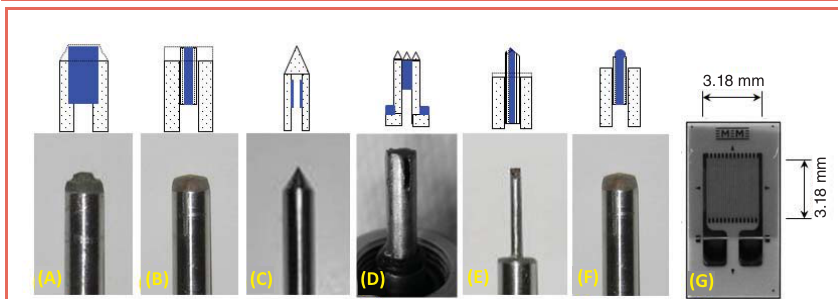
Figure 4. Measurement tools and sensors. [A] Bender elements for S-wave generation and detection. [B] Piezocrystals for P-waves. [C] Penetrometer for strength measurement. [D] Pore fluid sampler. [E] Electrical needle probe for resistivity profiling. [F] Thermocouple instrumented tip. [G] Strain gauge for thermal conductivity determination (TPS–NETL; Rosenbaum et al.,